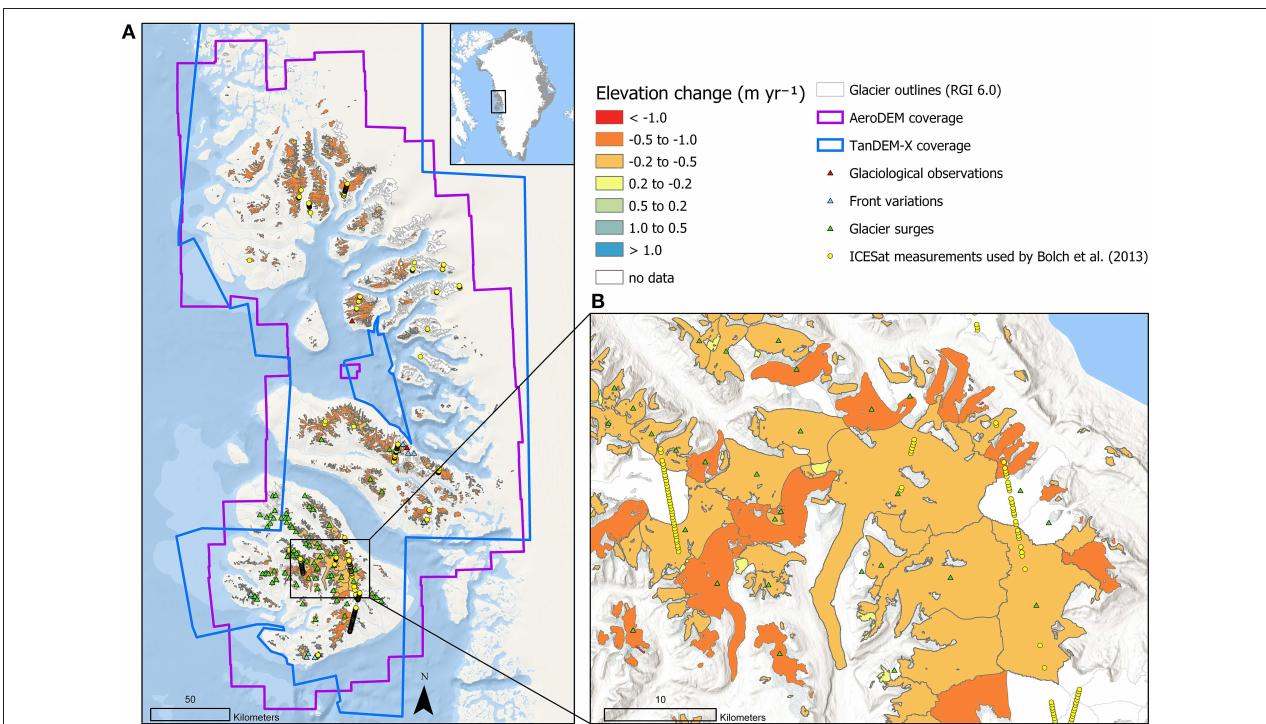
FIGURE 1 | Glacier elevation changes in west-central Greenland. (A) The overview map shows the glacierized areas as based on RGI 6.0 together with elevation change rates from AeroDEM (1985) and TanDEM-X (2012) as well as ICESat tracks used by Bolch et al. (2013) and available information in the FoG database of the WGMS. (B) The inset map shows a close up of the study region located on Disko Island. This extract is subsequently used for close ups in Figures 2 , 5 and Supplementary Figures 1 , 3 . Note that the points representing ICESat measurements (yellow points) are enlarged for visualization purposes and do not represent the actual